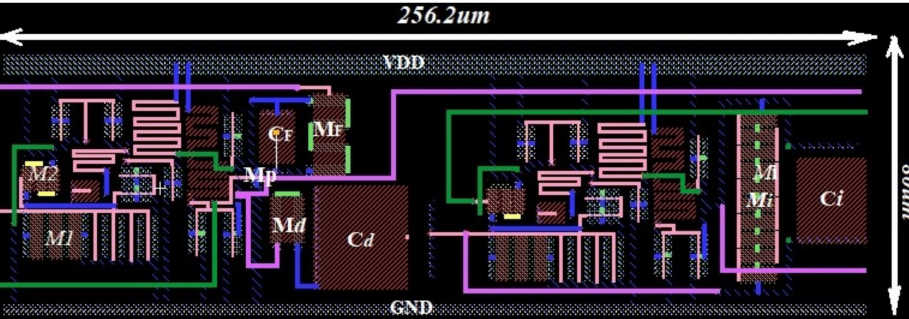
Figure 20. Core layout of the proposed readout